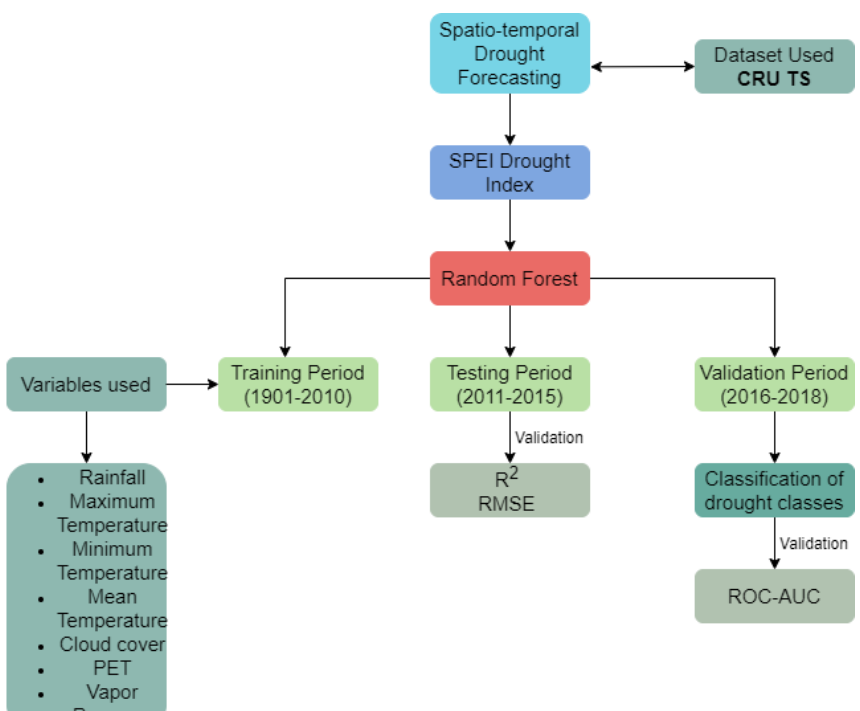
Figure 4. Flowchart of the work being conducted.